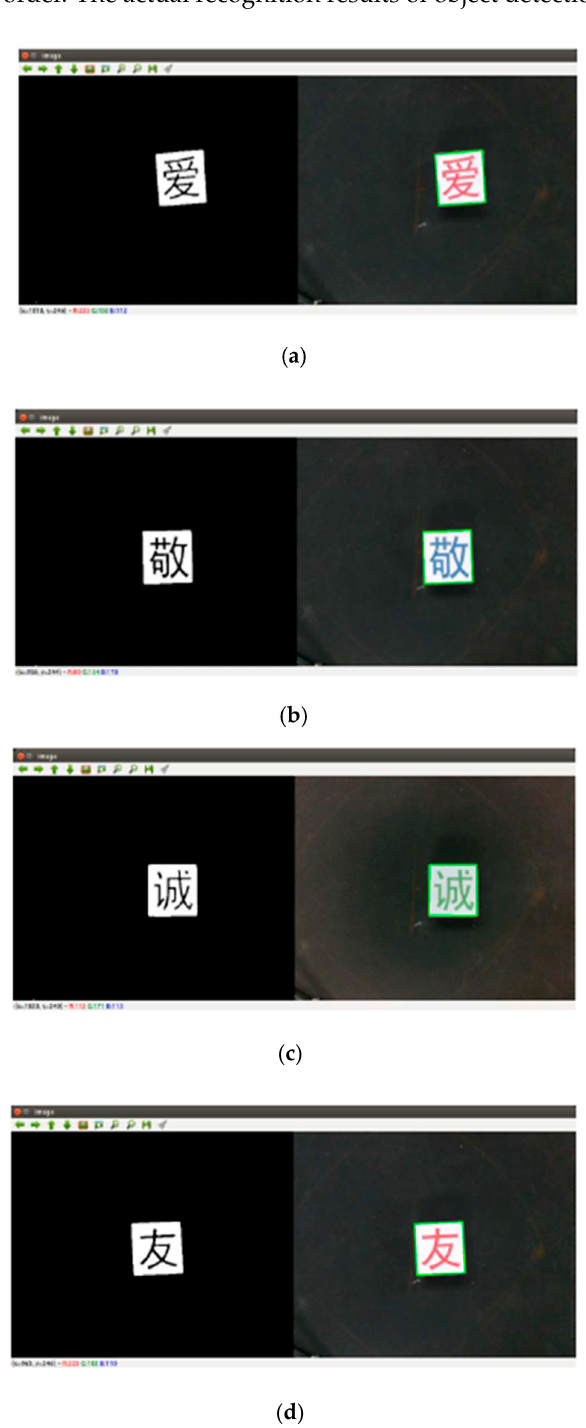
Figure 15. Actual recognition results of object detection. ( a ) Recognition result of Chinese character wooden block “ai”; ( b ) Recognition result of Chinese character wooden block “jing”; ( c ) Recognition result of Chinese character wooden block “cheng”; and ( d ) Recognition result of Chinese character wooden block “you”. wooden block